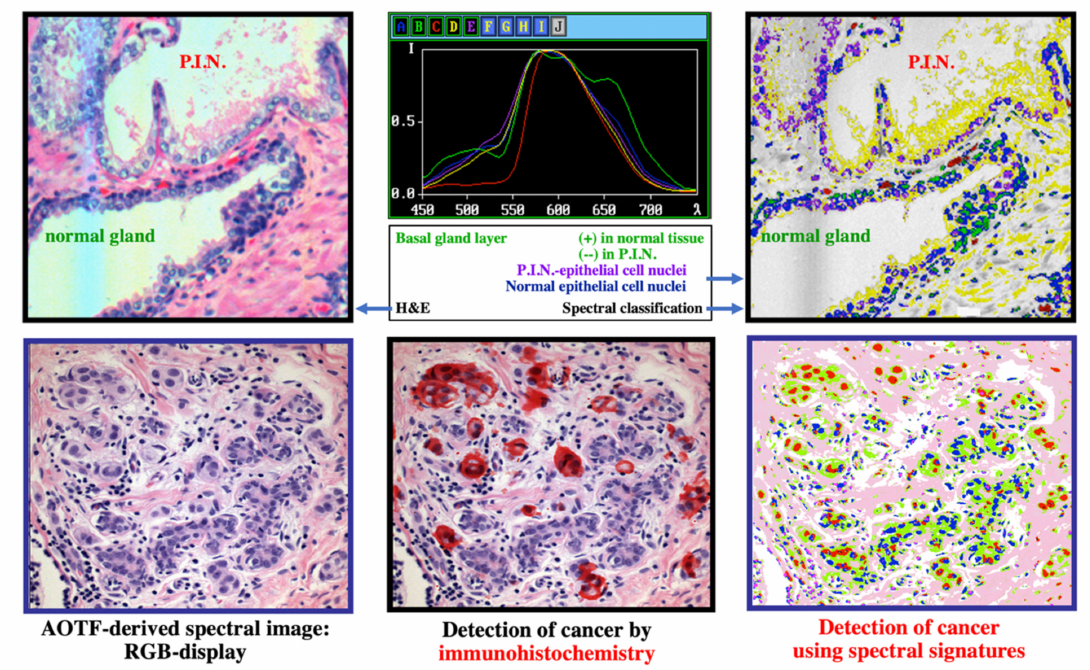
Figure 9. Spectral histopathology. Top: Prostate intraepithelial neoplasia (PIN). Left: RGB image of H&E specimen, difficult to evaluate. Middle: spectral signatures of different specimen areas. Right: spectrally segmented version of H&E image, showing normal gland (with a basal gland layer, in green pseudocolor), and PIN (without the basal layer). Bottom: Breast cancer. Left: RGB image of breast tissue (with a distant tumor that has infiltrated this area, in a difficult to assess way. Middle: Immunohistochemistry staining showing (in red) the cancer areas. Right: The same areas are identified and highlighted as cancerous based on spectral segmentation of just the H&E images (no extra staining